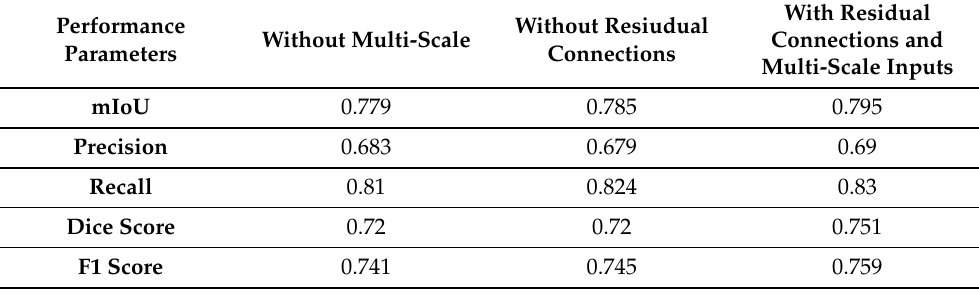
Table 3. Benchmarking results of the proposed Multi-Scale input Residual UNet (MSiR-UNet) architecture against its two versions, i.e., without multi-scale input and residual connections, by using various evaluation